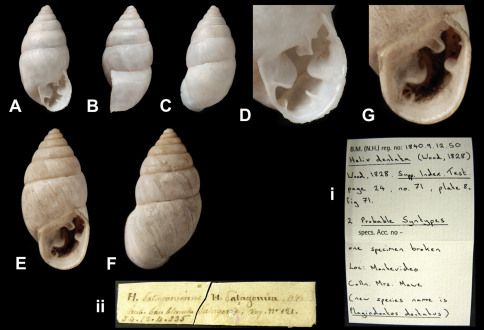
Plagiodontes species. A–D, i
Plagiodontes dentata (Wood, 1828), syntype NHM 1840.9.12.50 (H = 17.5) D detail of aperture E–G, ii
Plagiodontes patagonica (d’Orbigny, 1835), paralectotype NHM 1854.12.4.235 (H = 22.3) G detail of aperture.